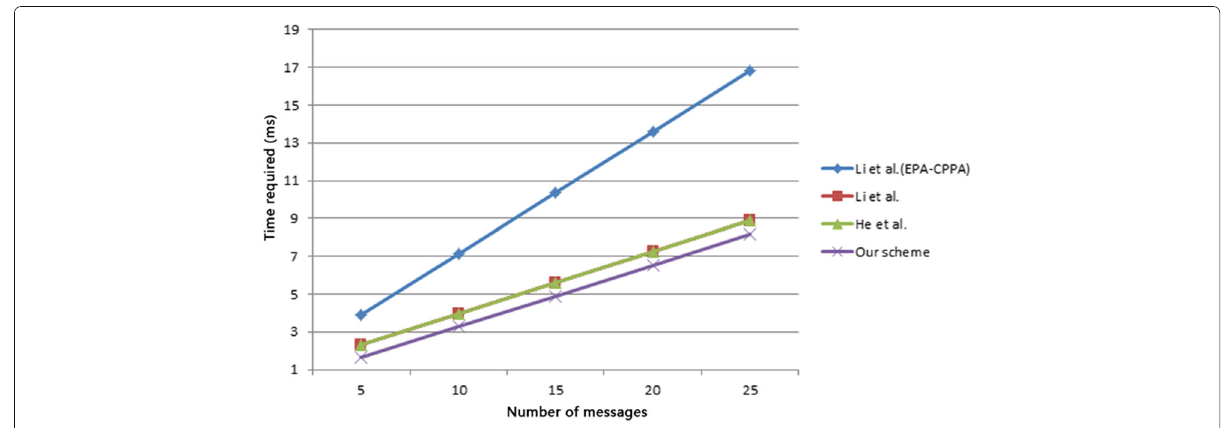
Fig. 5 Computation overhead of batch verifications